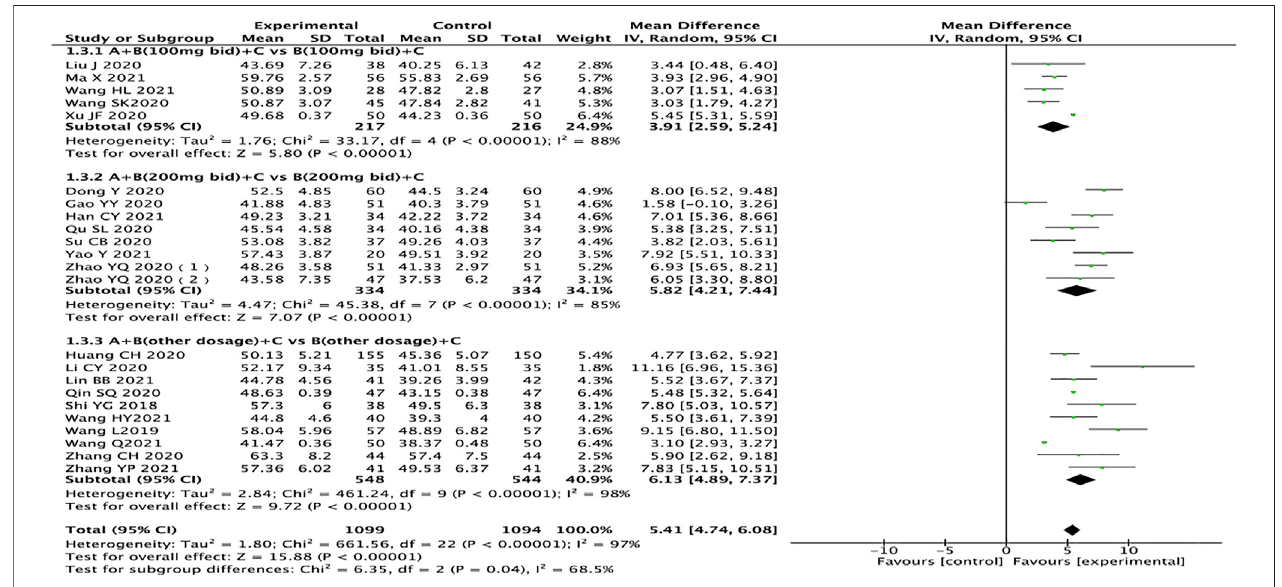
FIGURE 5 | Forest plot of